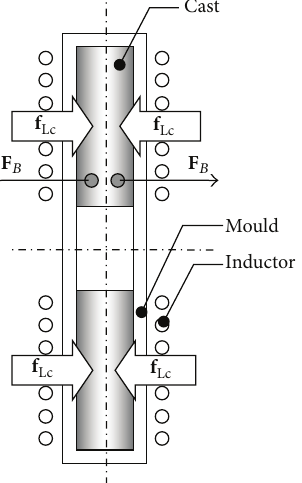
Figure 3: Distribution of the radial component of the Lorentz force at the wall on the inductor side: (a) standard inductor and (b) inductor with optimised geometry.